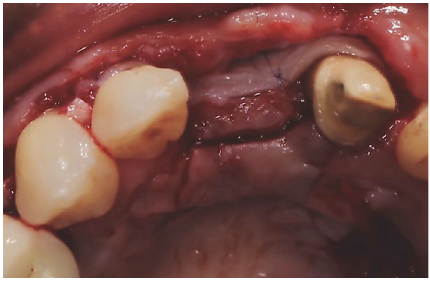
Figure 16: Connective tissue graft sutured on the buccal side. Coronal incision line of the palatal island fl ap is evident.